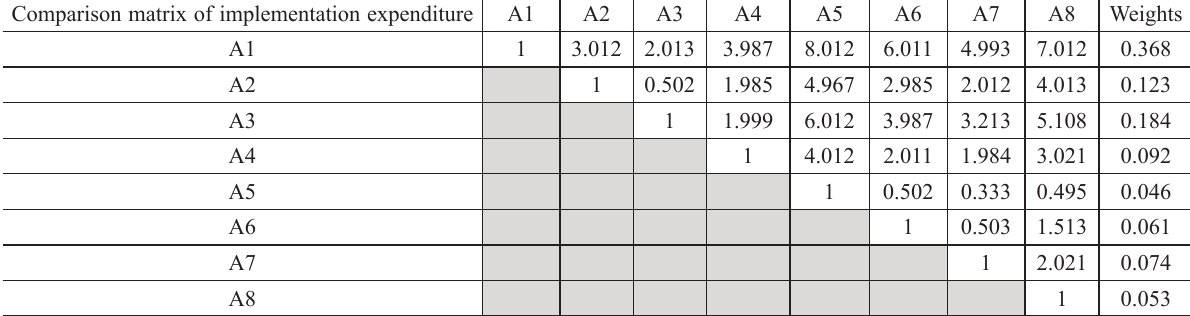
Table 9. Importance degree of any laminated glass models related to implementation expenditure Comparison matrix of implementation